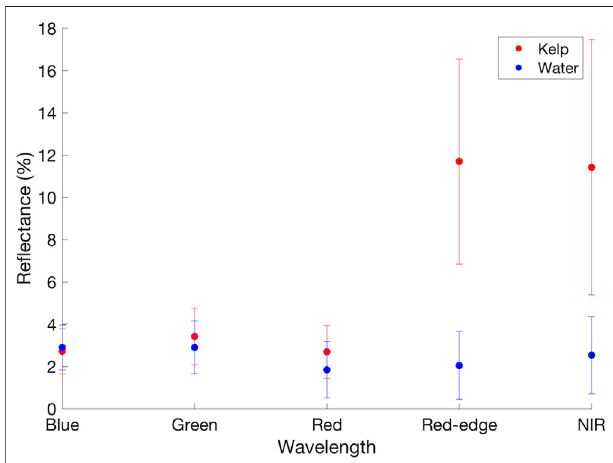
FIGURE5 | Mean and standard deviation forthe manually classi fi ed and digitizedkelpandwaterpixelsforfromtheblue,green,red,red-edge,andNIR bands. Thesevalueswereused asinputs tothe vegetation indices used inthe parametric separability analysis.